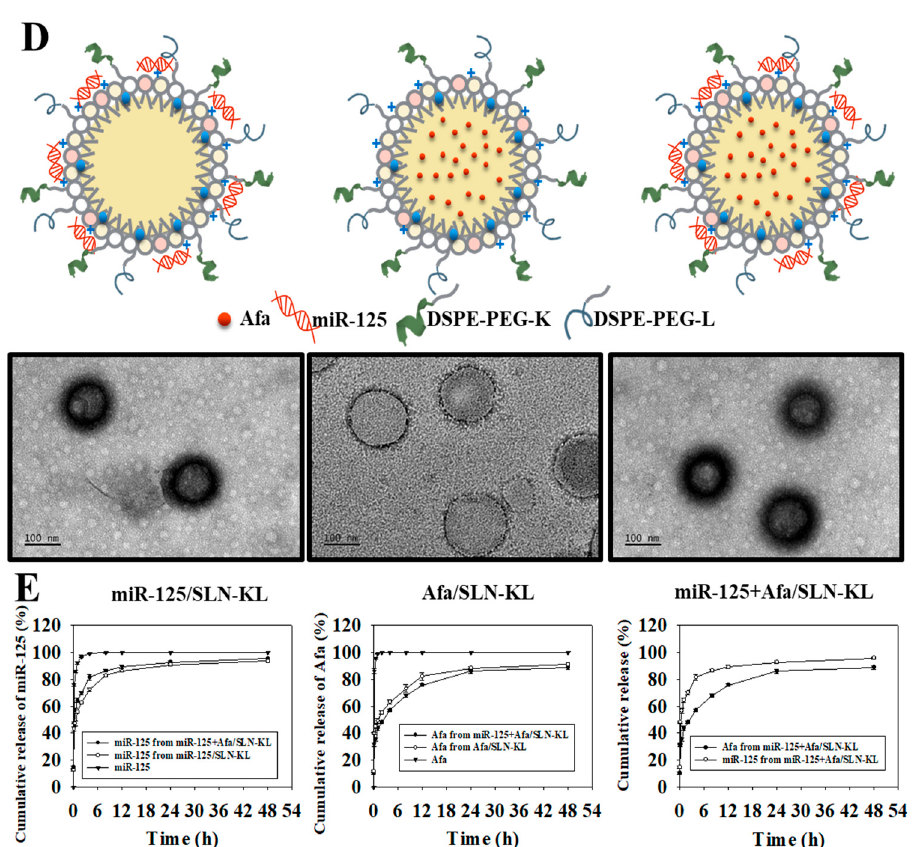
Figure 1. Rationale and physicochemical characterization of different miR ‐ 125 and/or Afa formula ‐ tions. ( A ) Rationale of reprogramming metabolic dysregulation and dysfunctional mitochondria in AGS cells by miR ‐ 125 + Afa/SLN ‐ KL. ( B ) Conjugation of DSPE ‐ PEG to ( up ) K peptide and ( down ) L peptide. ( C ) Sizes and zeta potential of ( left ) miR ‐ 125/SLN ‐ KL, ( middle ) Afa/SLN ‐ KL, and ( right ) miR ‐ 125 + Afa/SLN ‐ KL, as measured by Malvern Zetasizer. ( D ) TEM images of ( left ) miR ‐ 125/SLN ‐ KL, ( middle ) Afa/SLN ‐ KL, and ( right ) miR ‐ 125 + Afa/SLN ‐ KL, as observed using JEM ‐ 2000EXII TEM. Scale bar, 100 nm. ( E ) In vitro release profiles of miR ‐ 125 and/or Afa from SLN ‐ KL.